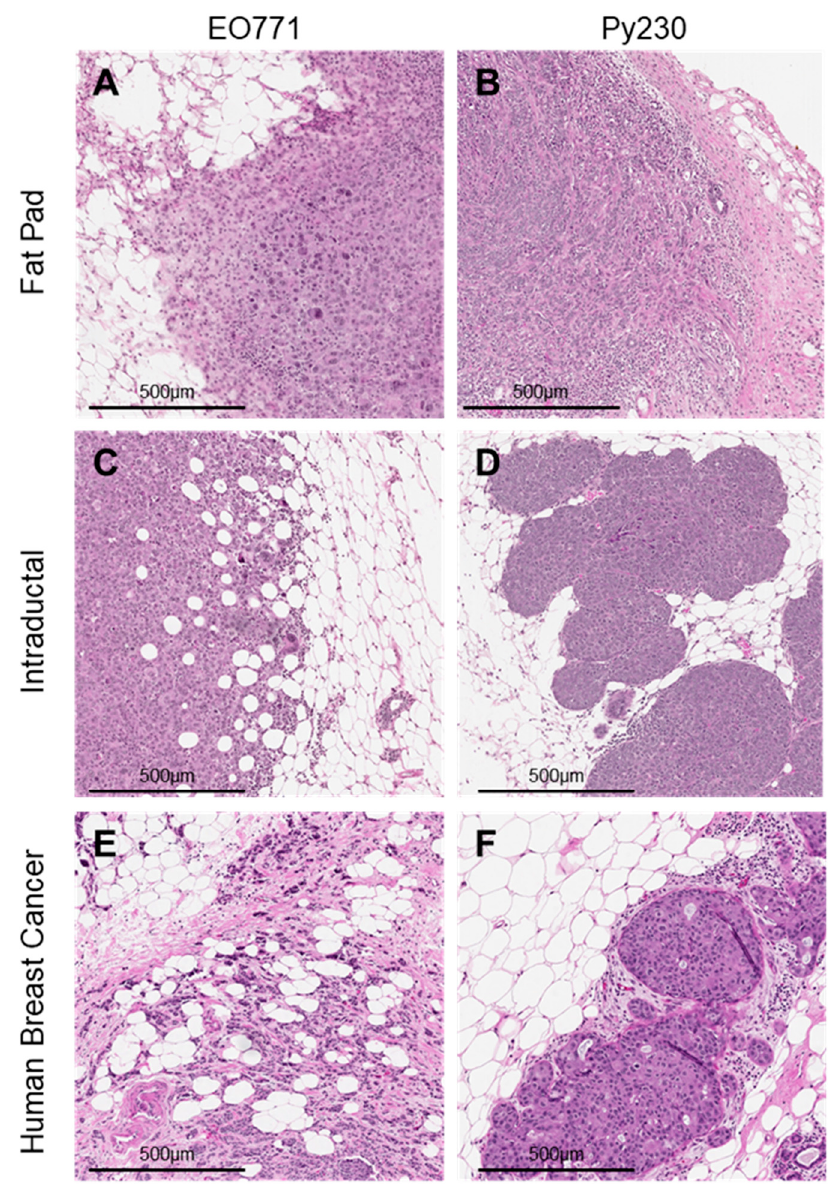
Figure 2. Histological analysis of tumors derived from intraductal injections, compared to mammary fat pad injections. Hematoxylin–eosin stains of tumors derived from the injection of murine mammary cell lines ( A ) EO771 (5 × 10 4 cells in 10 µL) or ( B ) Py230 (5 × 10 4 cells in 10 µL) into the 4th left mammary fat pad of C57BL/6 mice. In parallel, ( C ) EO771 (5 × 10 4 cells in 2 µL) or ( D ) Py230 (5 × 10 4 cells in 2 µL) were intraductally injected into the contralateral 4th right mammary gland. Hematoxylin–eosin stains of invasive human breast cancer samples characteristic of ( E ) in fi ltrating fat breast cancer and ( F ) ‘pushing’ border breast cancers.